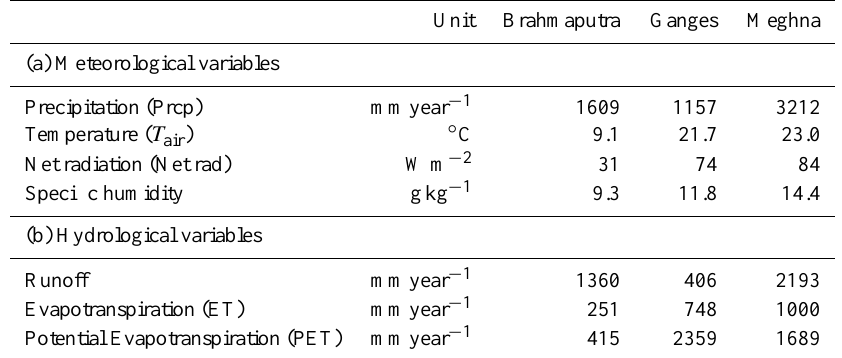
Table 5. The 22-year (1980–2001) averages of the meteorological (from the WFD forcing data) and hydrologic variables in the GBM river basins.